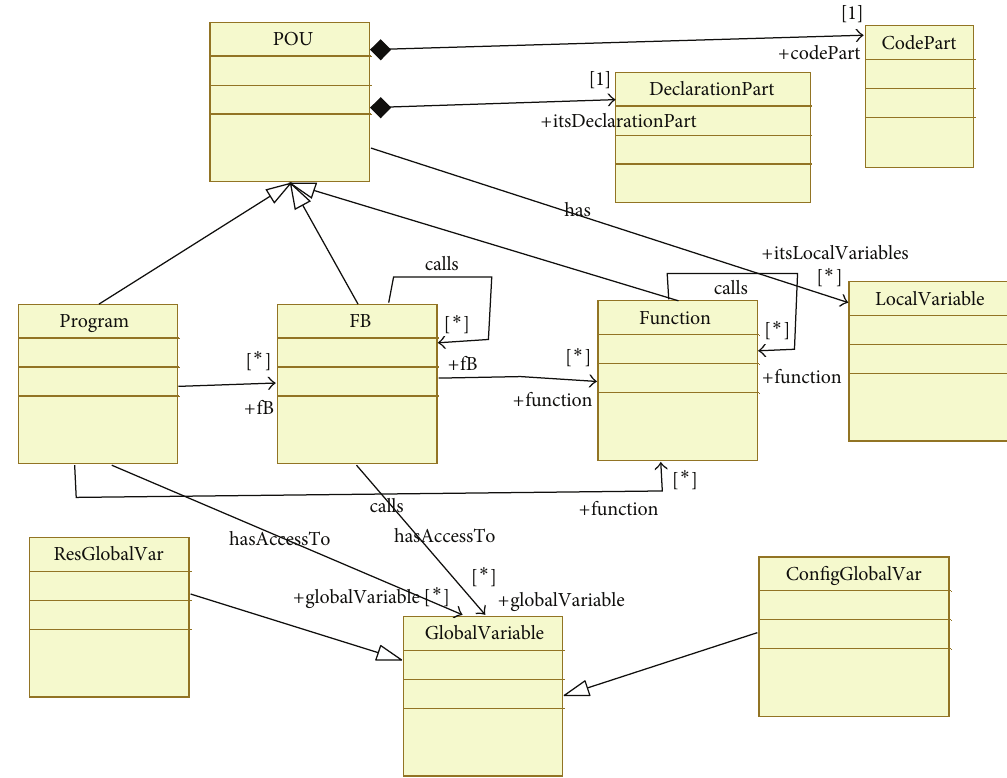
Figure 3: Key elements of the IEC 61131 software model regarding the organization of programs.